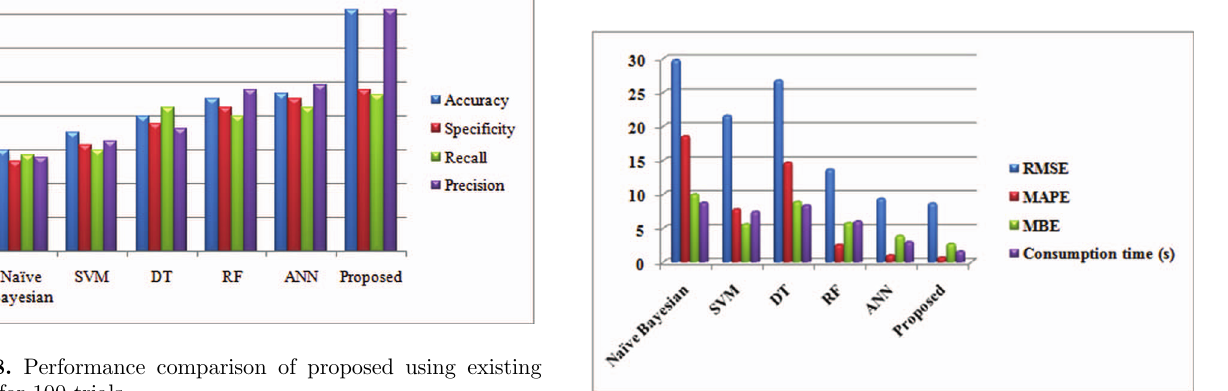
Fig. 18. Performance comparison of proposed using existing system for 100 trials.